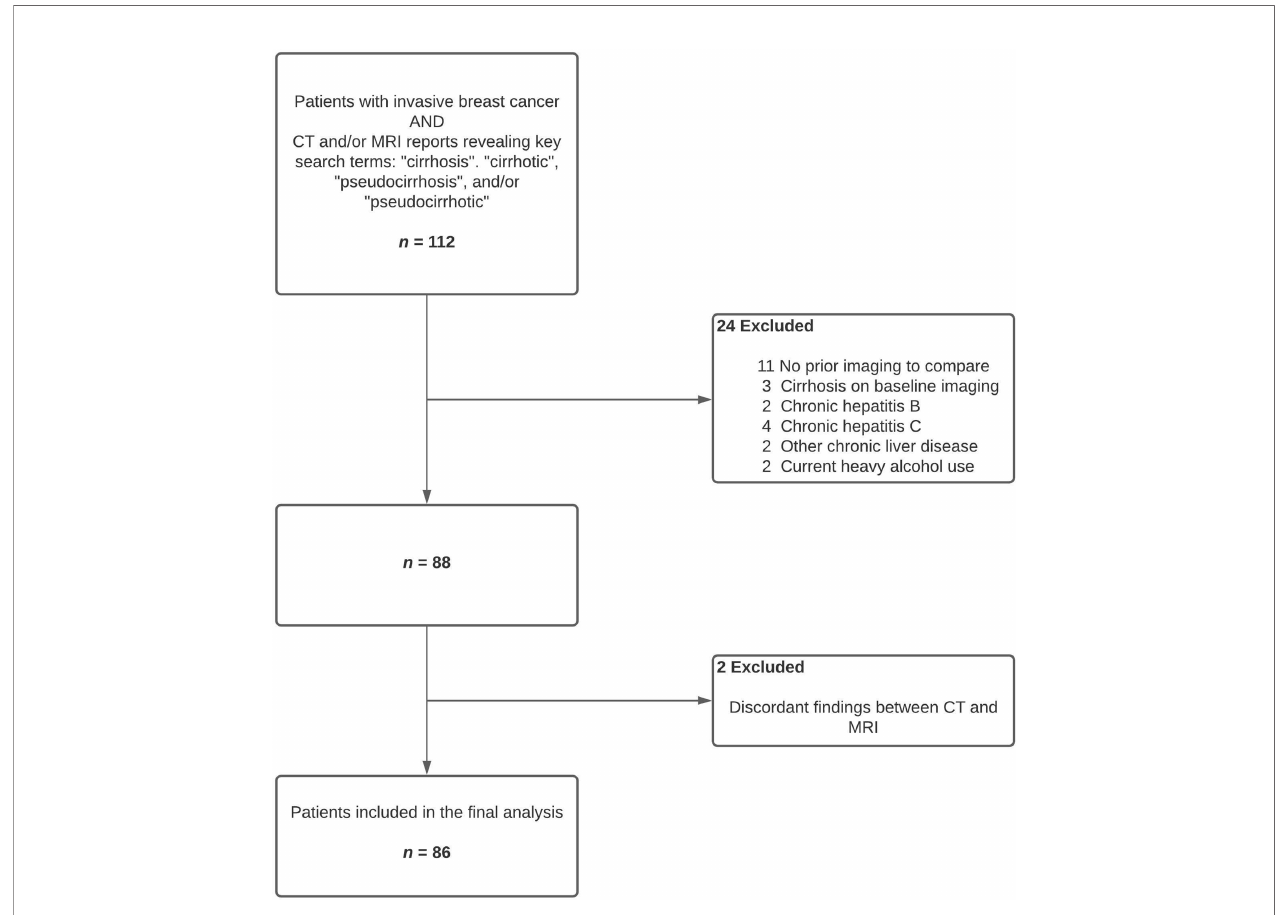
FIGURE 1 | Flow diagram depicting selection of the study